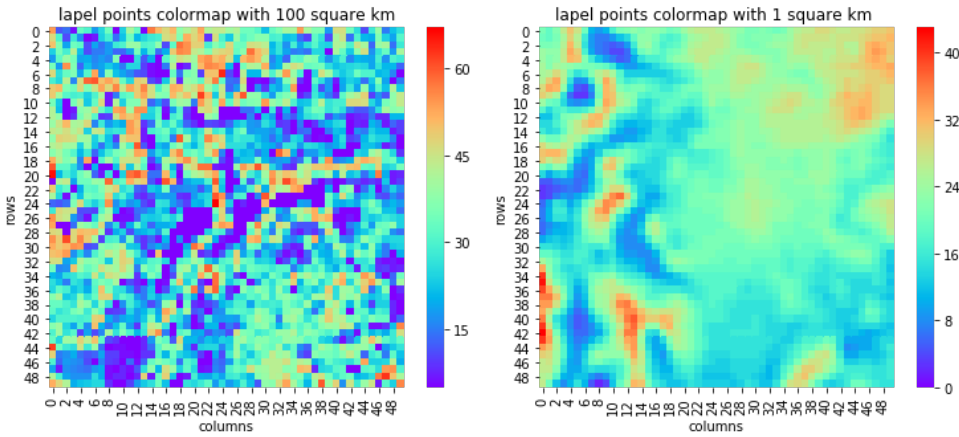
Figure 15. The heatmap of the lapel points. The size of the heatmap is related to the DEM area and the skyline sampling density. The dot ( i , j ) in the heatmap represents the number of lapel points of the skyline in row i and column j .